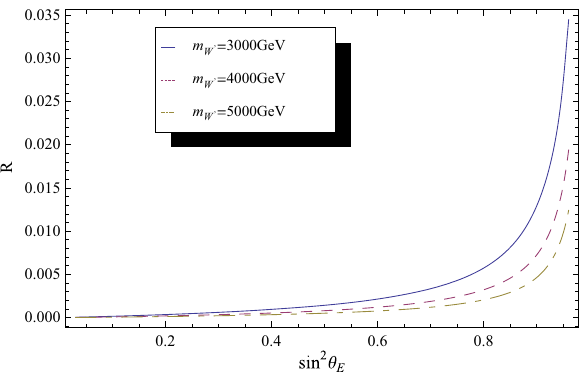
Fig. 3 The relative corrections of W (cid:2) predicted by the NU model to the decay B − → γ e − ¯ ν e as functions of sin 2 θ E in the down-quark mixing scenario